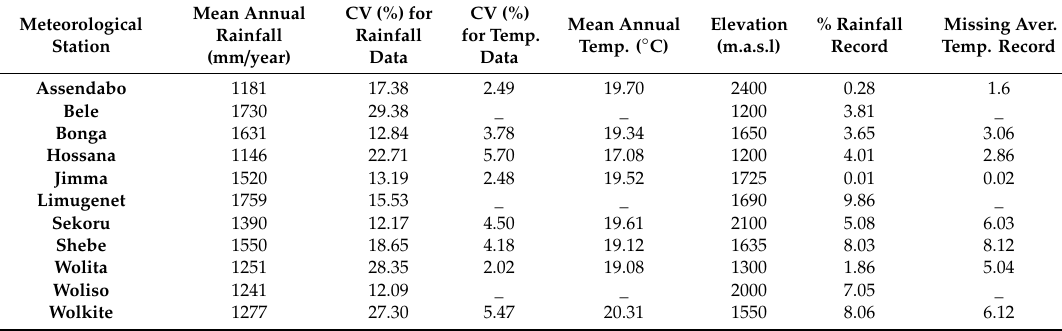
Table 2. Description of the meteorological stations in the upper Omo-Ghibe basin covering the period 1981–2008.